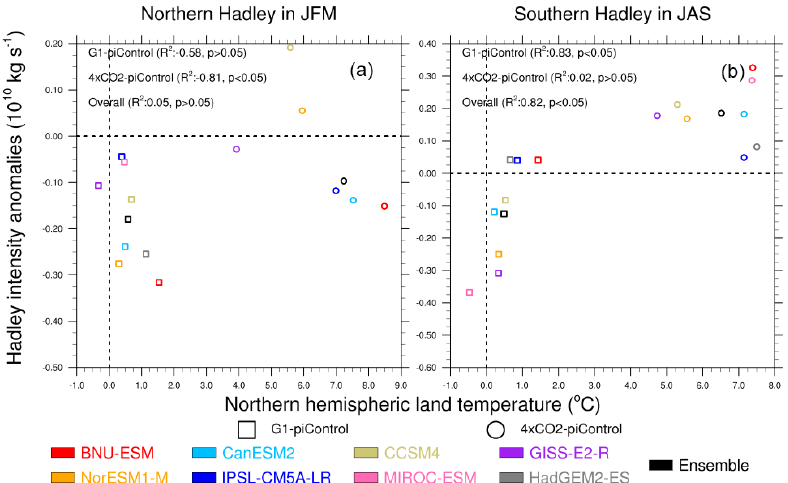
Figure 13. Hadley intensity mean model anomalies versus the Northern Hemisphere land temperature for the northern Hadley cell in JFM (a) and the southern Hadley cell in JAS (b) . A positive value of Hadley intensity indicates Hadley circulation strengthening regardless of the